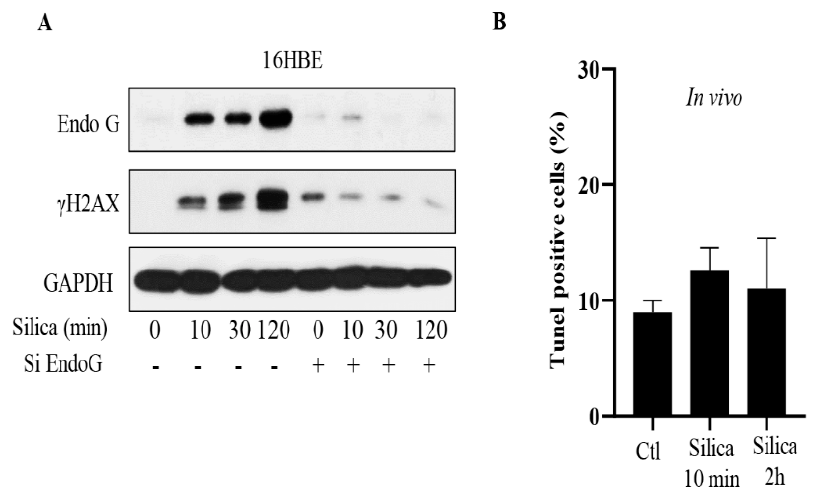
Figure 3. Inhibition of EndoG prevents silica-induced DNA damage. In ( A ), 16HBE cells were transfected with siRNA EndoG (30 pM) for 24 h, and then exposed to silica (5 µ g/cm 2 ) for times indicated. Cell lysates were analyzed for EndoG and γ H2AX by Western blotting. In ( B ), TUNEL assay was performed to assess apoptotic cells in mouse lung tissue. Quantification of TUNEL positive cells was analyzed by Image J software. Bars show means ± SD. All experiments were performed at least in triplicate.